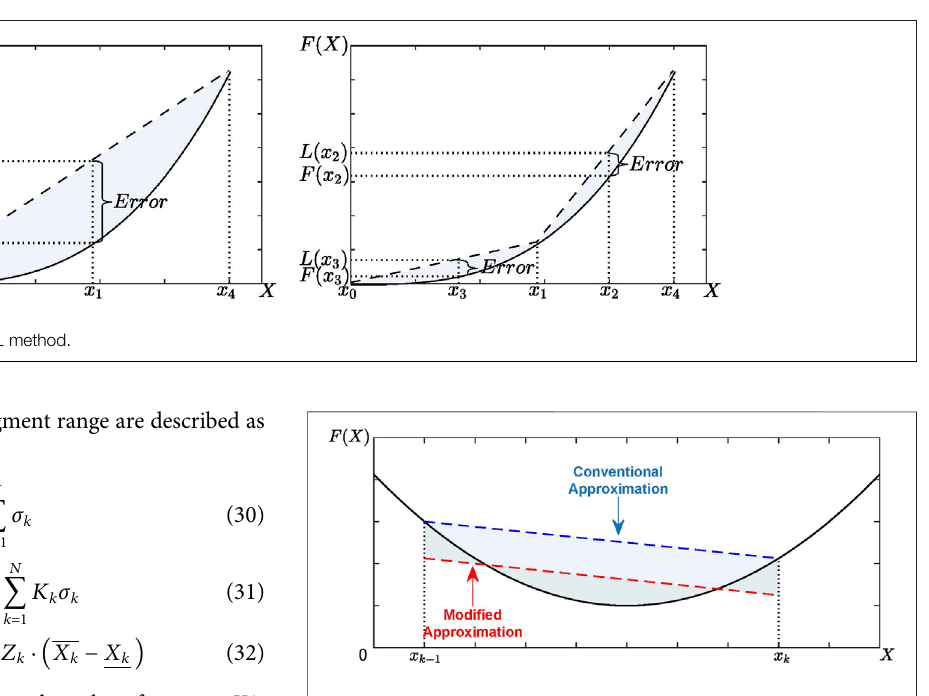
FIGURE 3 | Vertical Modi fi cation for PWL